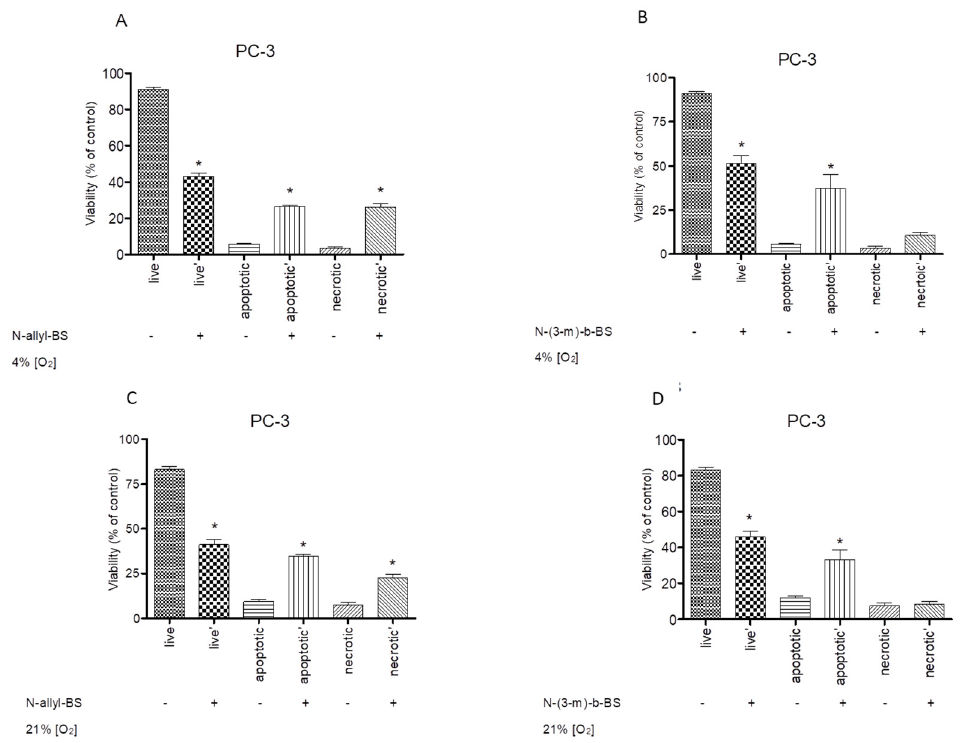
Figure 9. 40 µ M N -allyl-BS and N -(3-mb)-BS exhibit similar cytotoxic activity towards PC-3 cells both in hypoxic and normoxic conditions ( A – D ). The cells were treated with indicated concentration of N -allyl-BS or N -(3-mb)-BS for 24 h. The viability was assessed using flow cytometry. Data are presented as mean ± SE (n = 3); significant di ff erence was calculated using one-way ANOVA followed by Dunnett’s multiple comparison test (* P < 0.01).